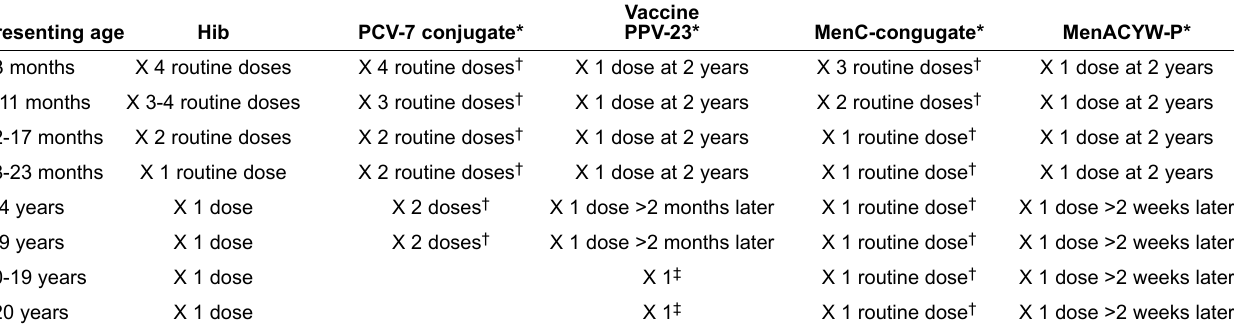
TABLE 5 Recommendations for vaccines against encapsulated bacteria for children considered to be at high risk for these